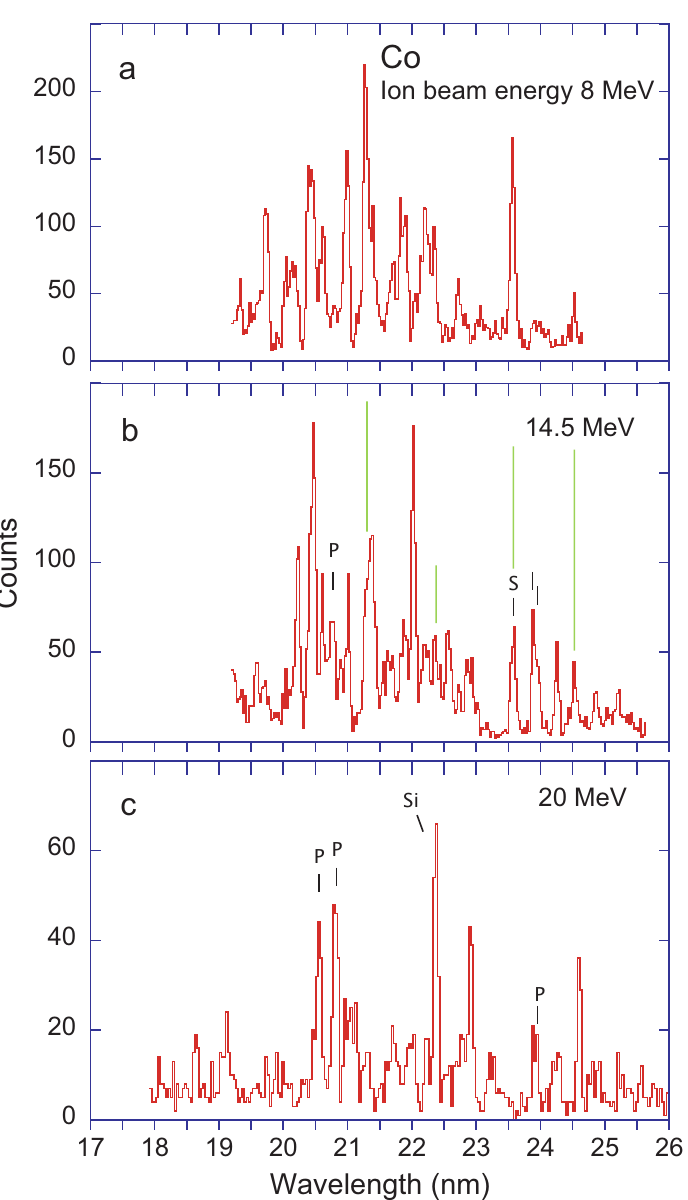
Figure 25. Beam-foil spectra of Co at different ion beam energies, but of a zone at the same 10mm distance from the exciter foil. All three observations used 100 µ m wide spectrometer slits and therefore feature a line width (FWHM) of 0.075nm. Observation ( a ) ion beam energy 8MeV, delay after excitation 2ns; ( b ) ion beam energy 14.5MeV, delay 1.5ns; ( c ) ion beam energy 20MeV, delay 1.2ns. Several lines are marked by their isoelectronic sequence. Vertical green lines indicate candidates for wavelength reference transfer